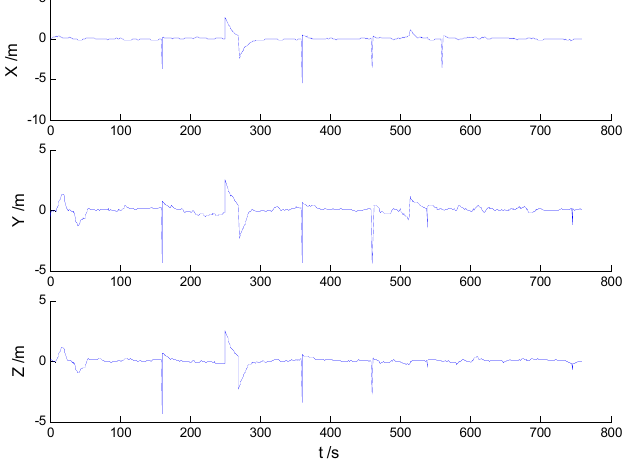
Figure 10. Position errors of the KF algorithm.